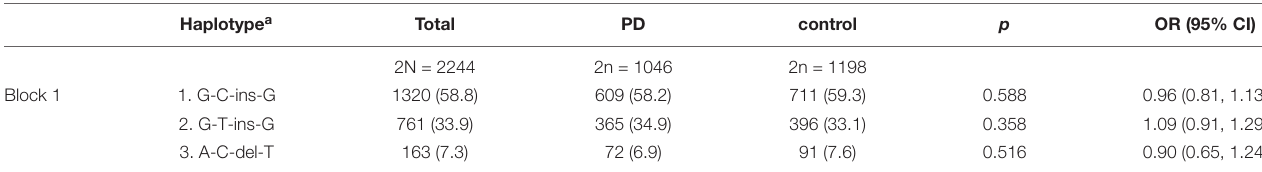
TABLE 4 | Haplotype frequencies of the four variations in DJ-1 promoter